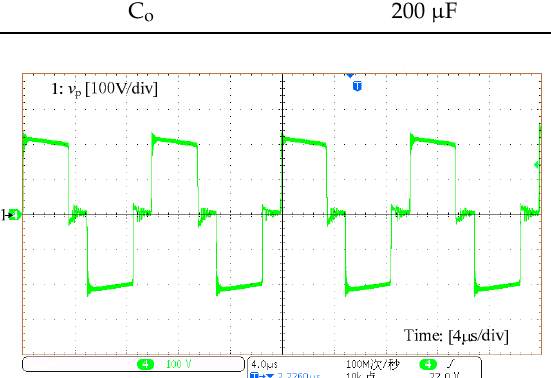
Figure 6. Waveform of v p .